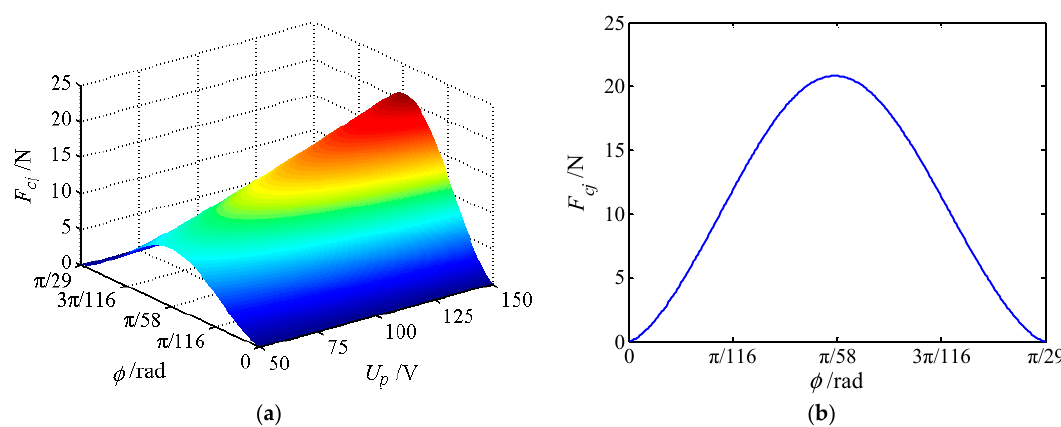
Figure 10. The force of movable tooth F sj . ( a ) The force varies with rotational angle and voltage; ( b ) force sectional view at U p = 150 V.